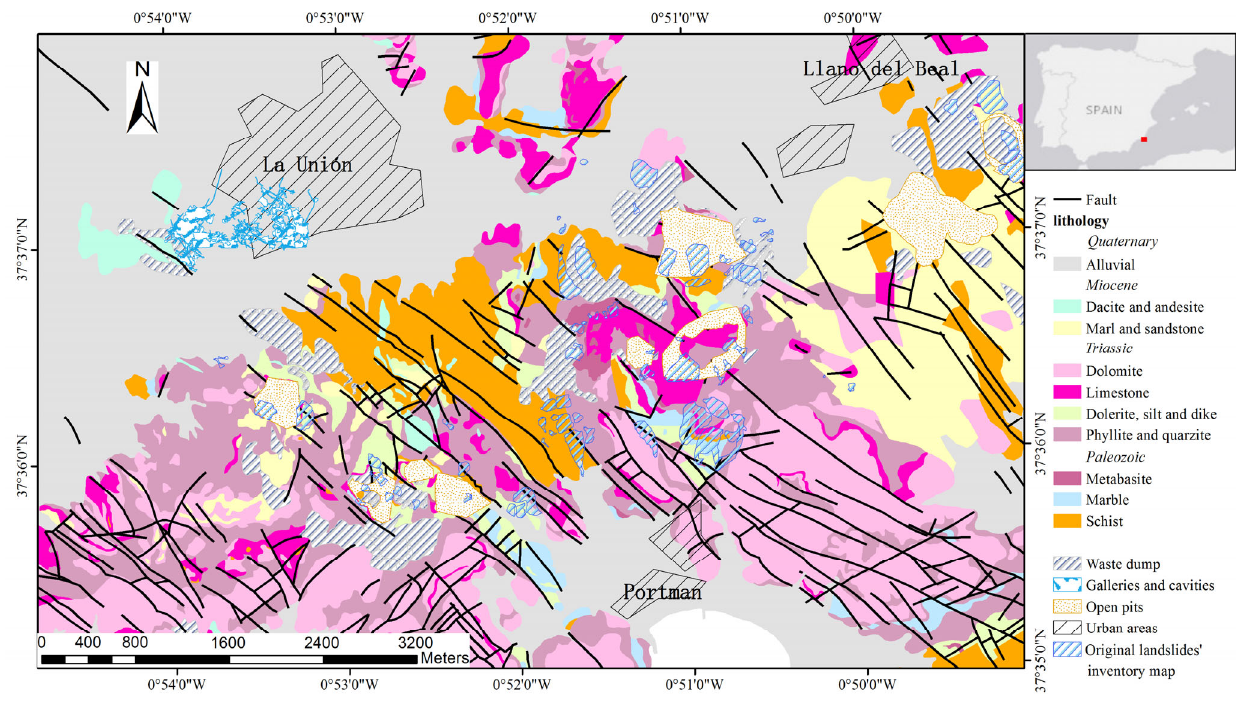
Figure 1. Geological map of the study area adapted from [22].